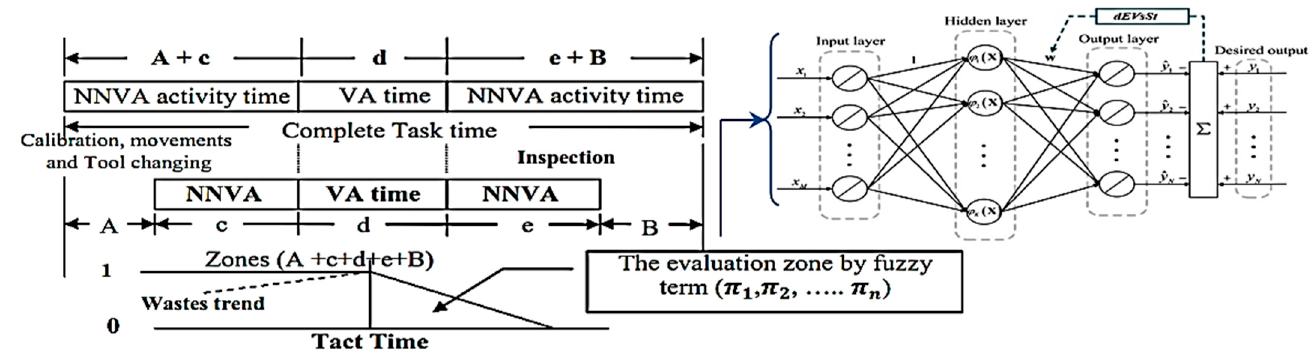
Figure 6. The perspective of procedures for EVs charging process at requested.